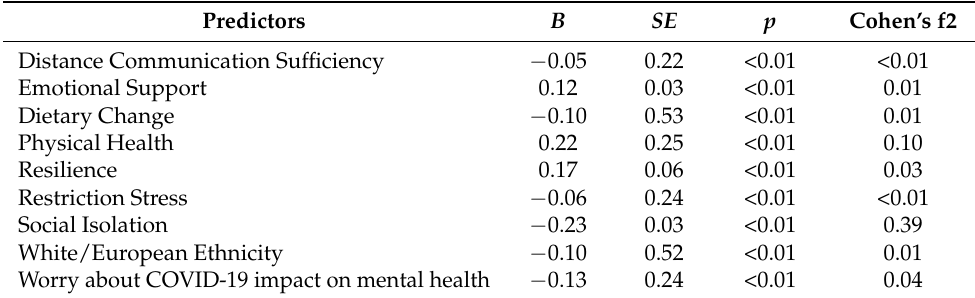
Table 2. OLS model for psychological